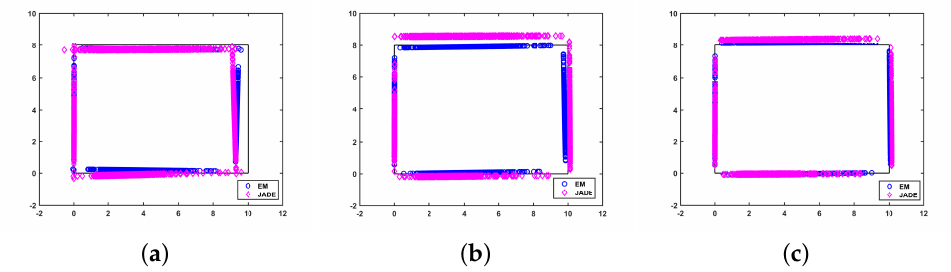
Figure 6. The mapping performance for different standard deviations of AOA errors: N = 500.